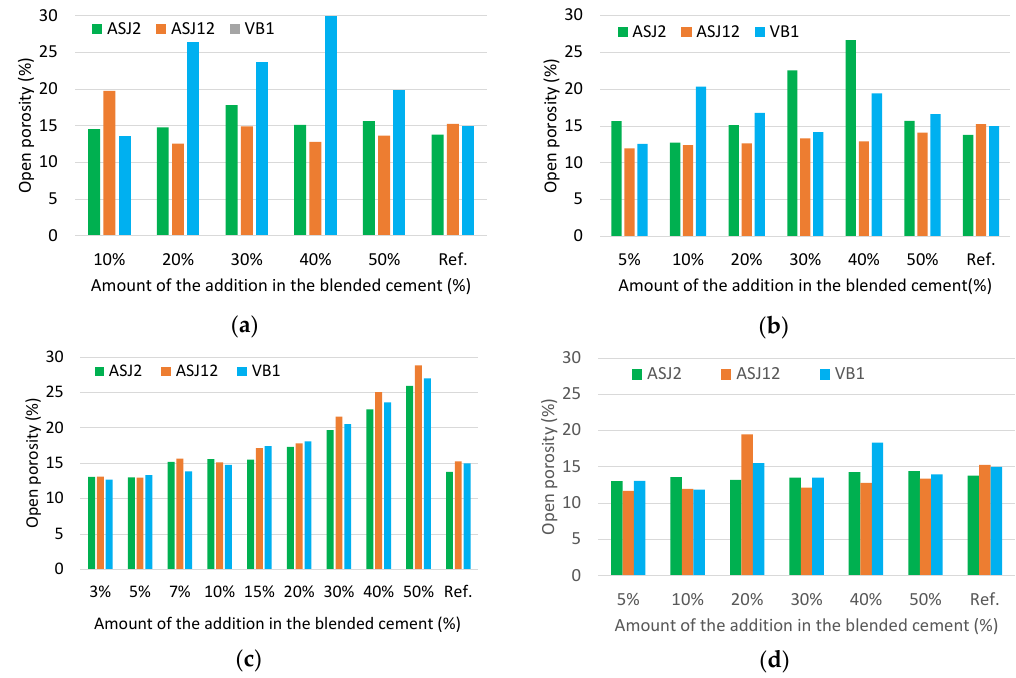
Figure 5. Open porosity results of the mortars made with the three aggregates and four additions added in four percentages of 20%, 30%, 40% and 50%: ( a ) natural pozzolan, P; ( b ) siliceous coal fly ash, V; ( c ) silica fume, D; ( d ) blast-furnace slag, S.